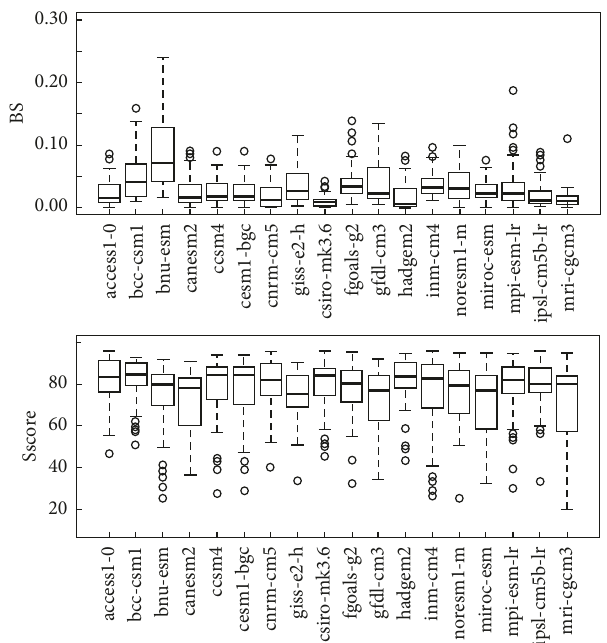
Figure 8: Box plots of BS and Sscore values for the PDF-based performance scores for monthly precipitation across all grid points in the Yellow-Huai-Hai basin (unit: %).